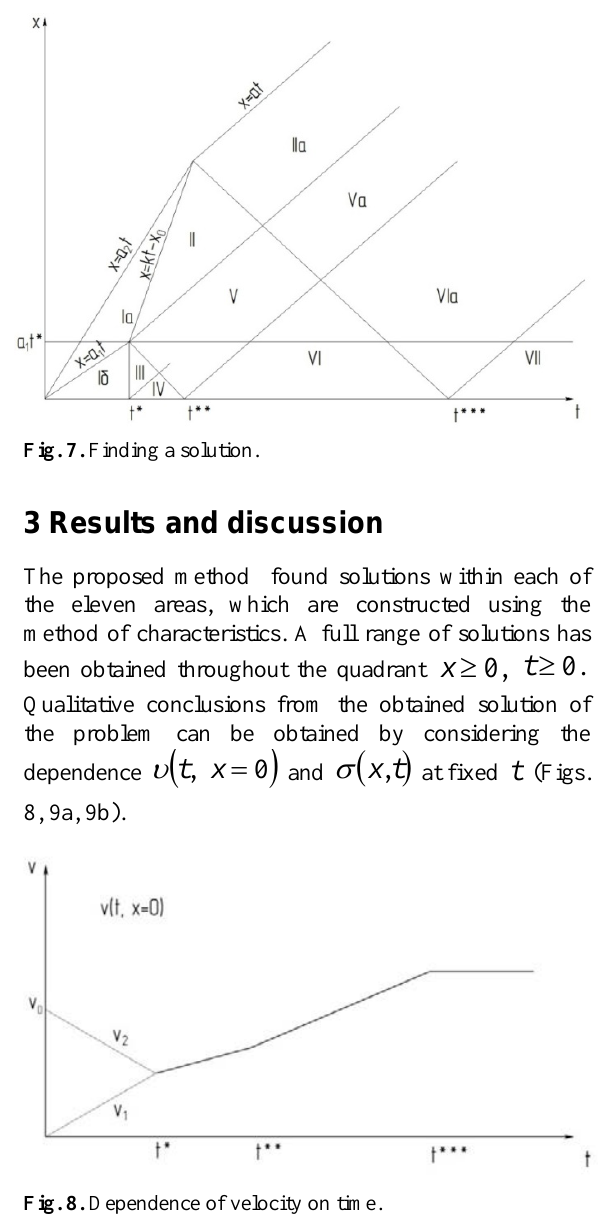
* tt = υ increases 1 * υ and the